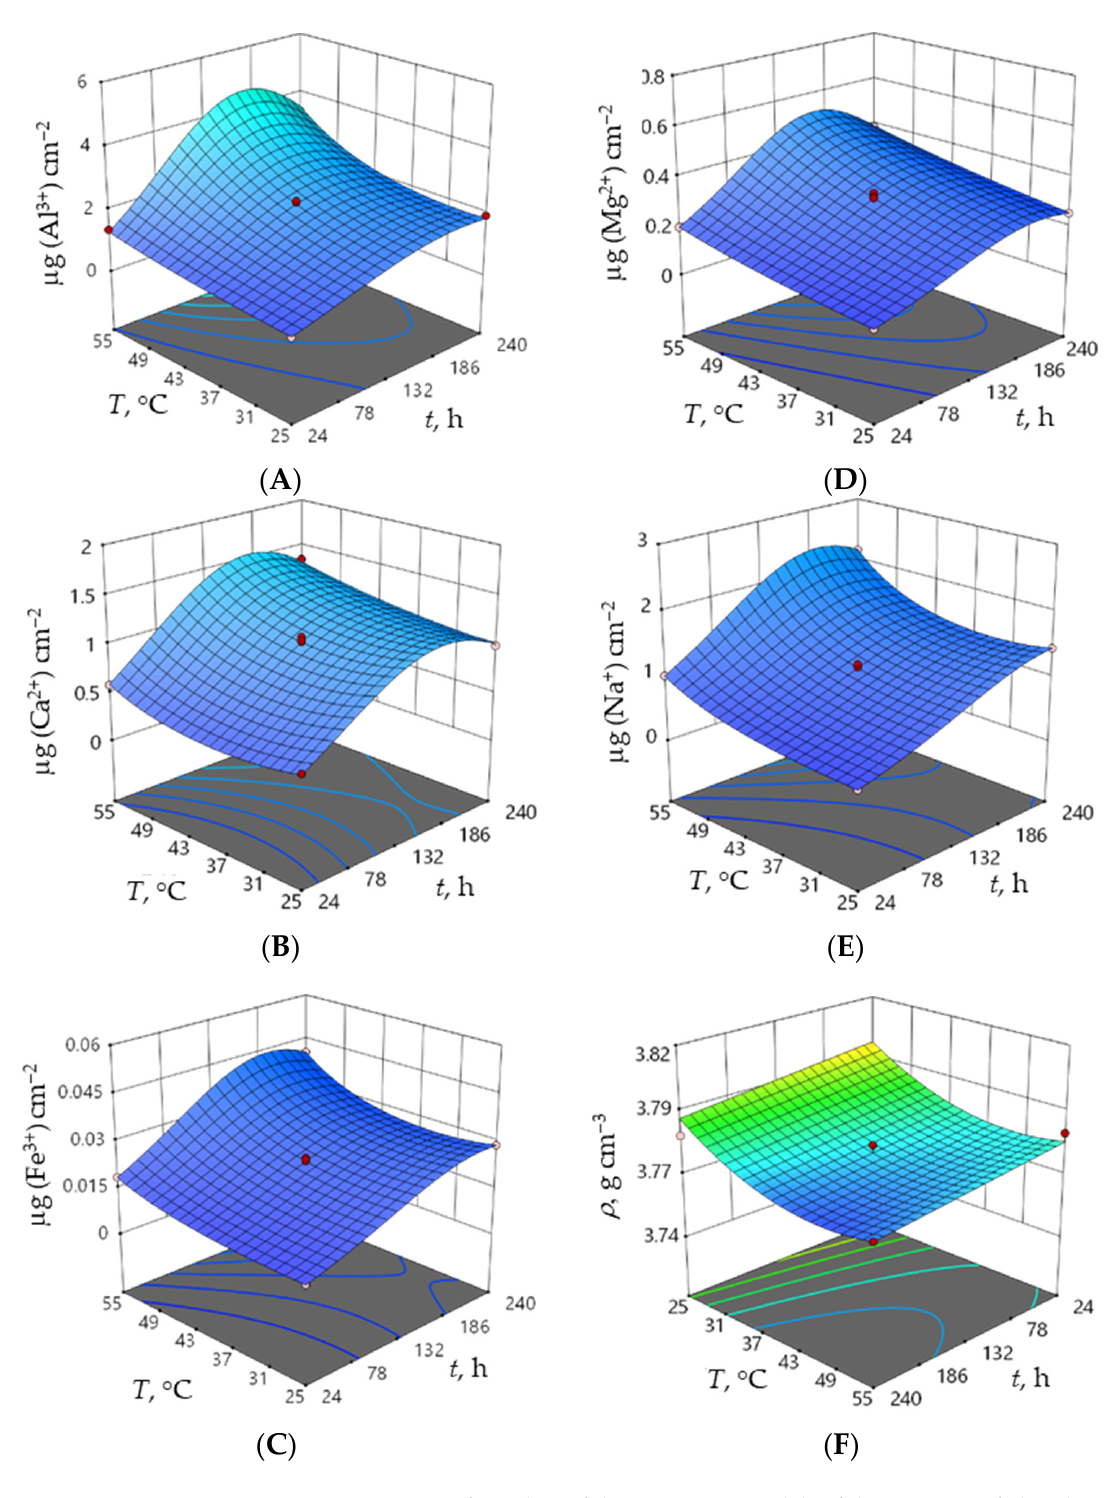
Figure 6. Response surface plots of the regression models of the amounts of eluted ions ( A ) Al 3+ , ( B ) Ca 2+ , ( C ) Fe 3+ , ( D ) Na + , ( E ) Mg 2+ and ( F ) the density of alumina ceramics at a constant concentration (1.25 mol dm – 3 ) of nitric acid.